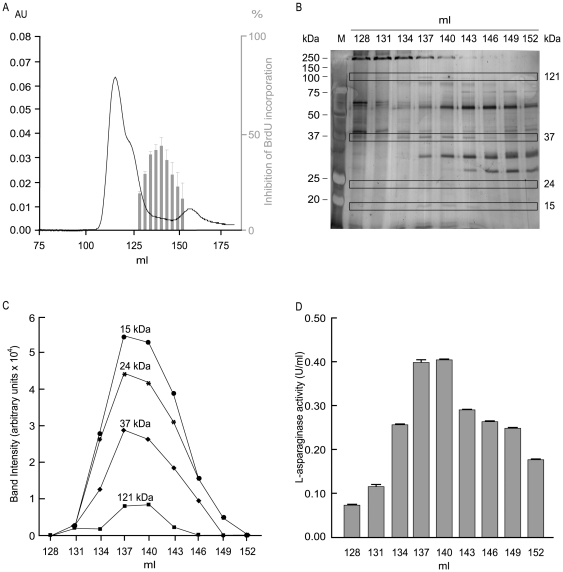
Isolation of the cell-cycle inhibiting activity from BCF.(A) Elution profile of BCF (black line) and cell-cycle inhibiting fractions identified by BrdU incorporation in HDF cells (grey histograms). (B) Active fractions separated on a non-reducing SDS gel. The four silver-stained bands of different molecular weights analysed by LC-MS/MS are in rectangles. (C) Stacked line representation of the relative intensities displayed by each of the bands detected in SDS-PAGE in (B). Numbers correspond to molecular masses in kDa. (D) L-asparaginase activity of cell-cycle inhibiting fractions.